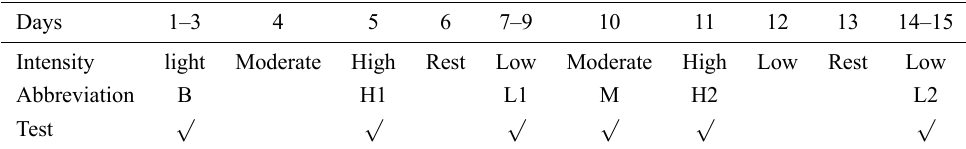
Table 2. Training schedule and test